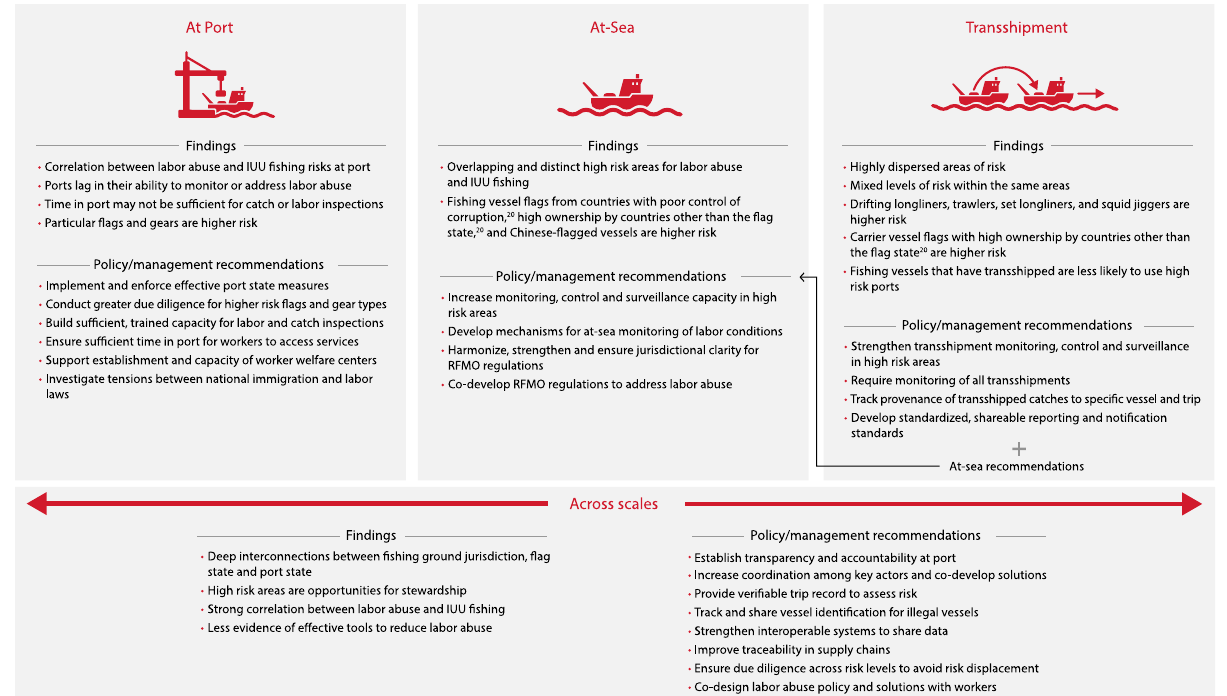
Fig. 5 Conceptual framework linking results to key recommendations for mitigating risks of labor abuse and IUU fi shing at port, at sea, and with transshipment. Key actors, including governments, companies, Regional Fisheries Management Organizations, and civil society organizations, will need to actively coordinate and consult with each other on most of the proposed recommendations. Certain actors may need to play lead roles in particular recommendations. For example, governments and Regional Fisheries Management Organizations could lead on strengthening data sharing systems and creating enforcement strategies based on risk, companies on fostering supply chain transparency and traceability, and civil society groups on helping to ensure representation across stakeholders.